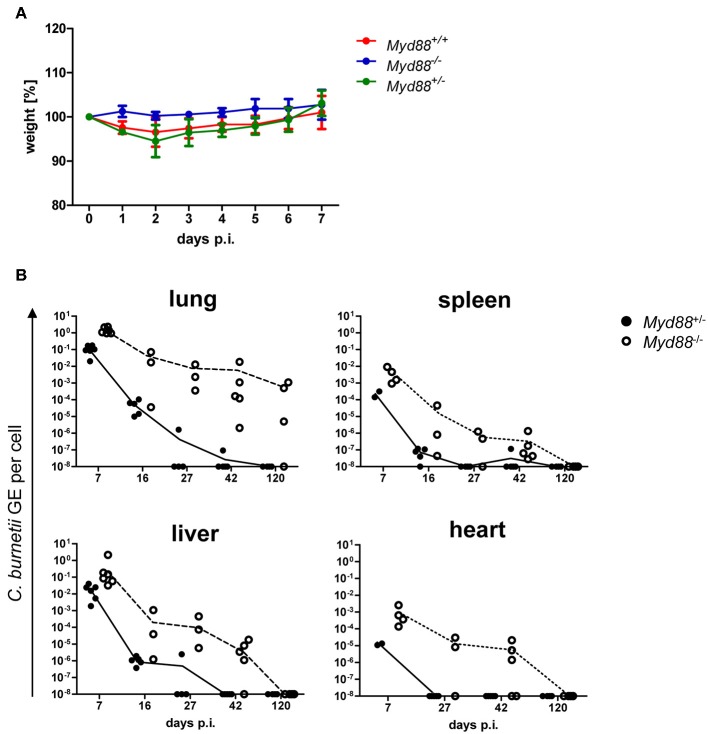
Kinetics of C. burnetii persistence after intratracheal infection. Intratracheal infection of mice was performed with 106 CFU C. burnetii NMII. (A) The weight of the mice was recorded daily for 7 days and changes relative to d0 are depicted as mean +/− SD (n = 4 for Myd88+/+ and for Myd88+/−, n = 2 for Myd88−/−). (B) mice were sacrificed on day 7, 16, 27, 42, or 120 post infection. Bacterial load in lung, spleen, liver and heart was determined via qPCR as NMII GE per cell. Every single dot in the graphs represents one single mouse.